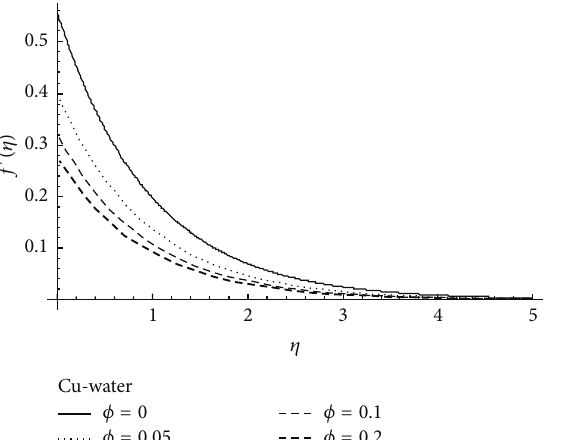
Figure 14: Effect of the volume friction 𝜙 of Cu-water nanoparticles on velocity distribution 𝑓 󸀠 (𝜂) when 𝑃𝑟 = 6.2 , 𝑠 = 0.5 , 𝛿 1 = 1 , and = −1 . 𝛿 2